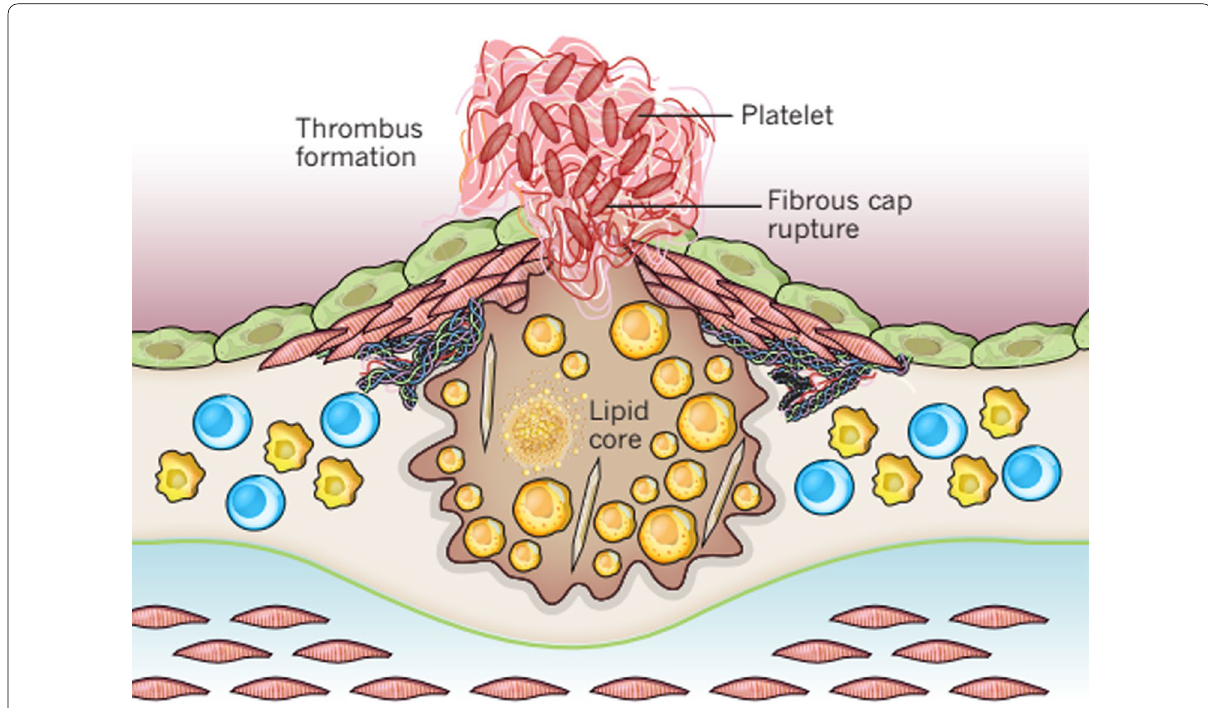
Fig. 4 Thrombosis. It is the ultimate complication of atherosclerosis, often complicates a physical disruption of the atherosclerotic plaque. A fracture of the plaque’s fibrous cap, which has enabled blood coagulation components to come into contact with tissue factors in the plaque’s interior, triggering the thrombus that extends into the vessel lumen, where it can impede blood